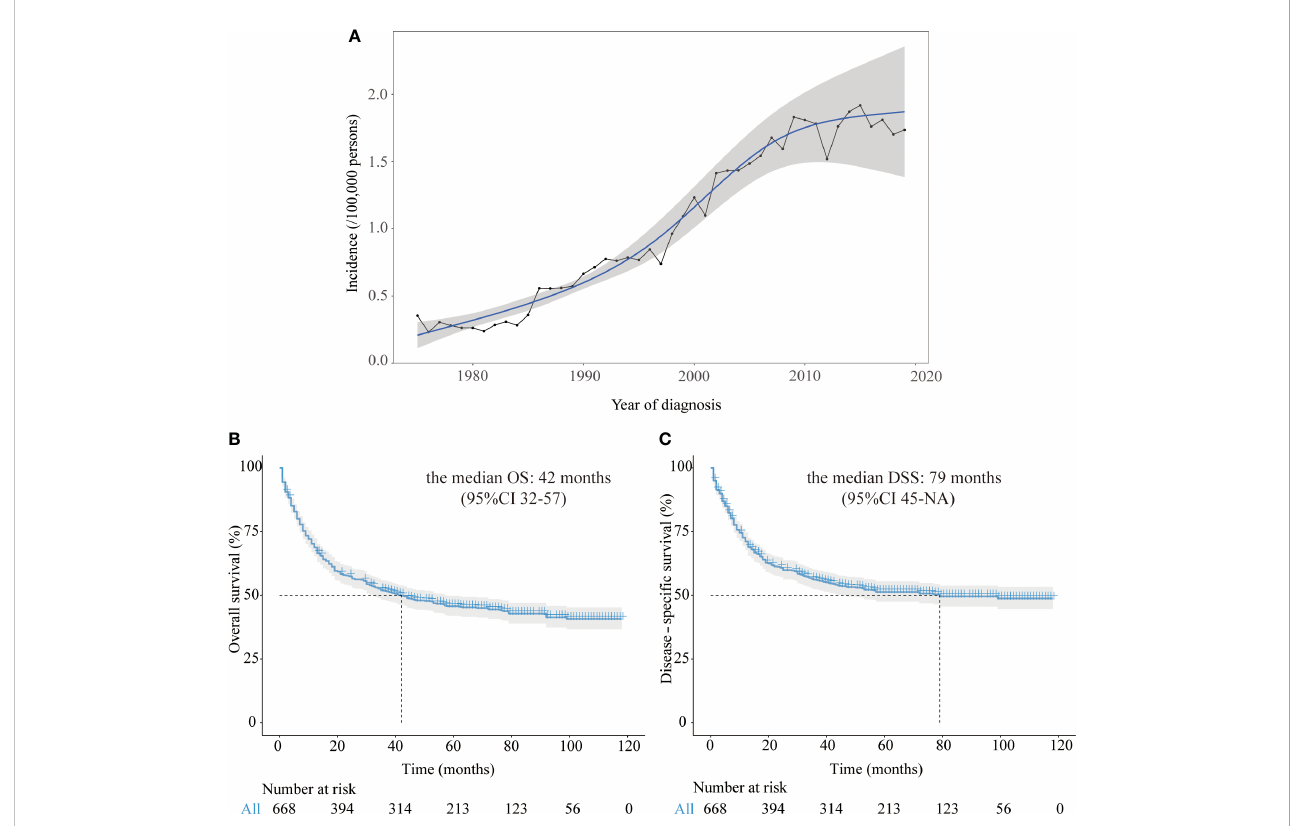
FIGURE 1 (A) The annual age-adjusted incidence of all CRNENs patients from 1975 to 2019. (B) Kaplan-Meier curves of OS in CRNENs patients from 2010 to 2016. (C) Kaplan-Meier curves of DSS in CRNENs patients from 2010 to 2016. CRNENs, colorectal neuroendocrine neoplasms, OS, overall survival; DSS, disease-speci fi c survival; NA, not